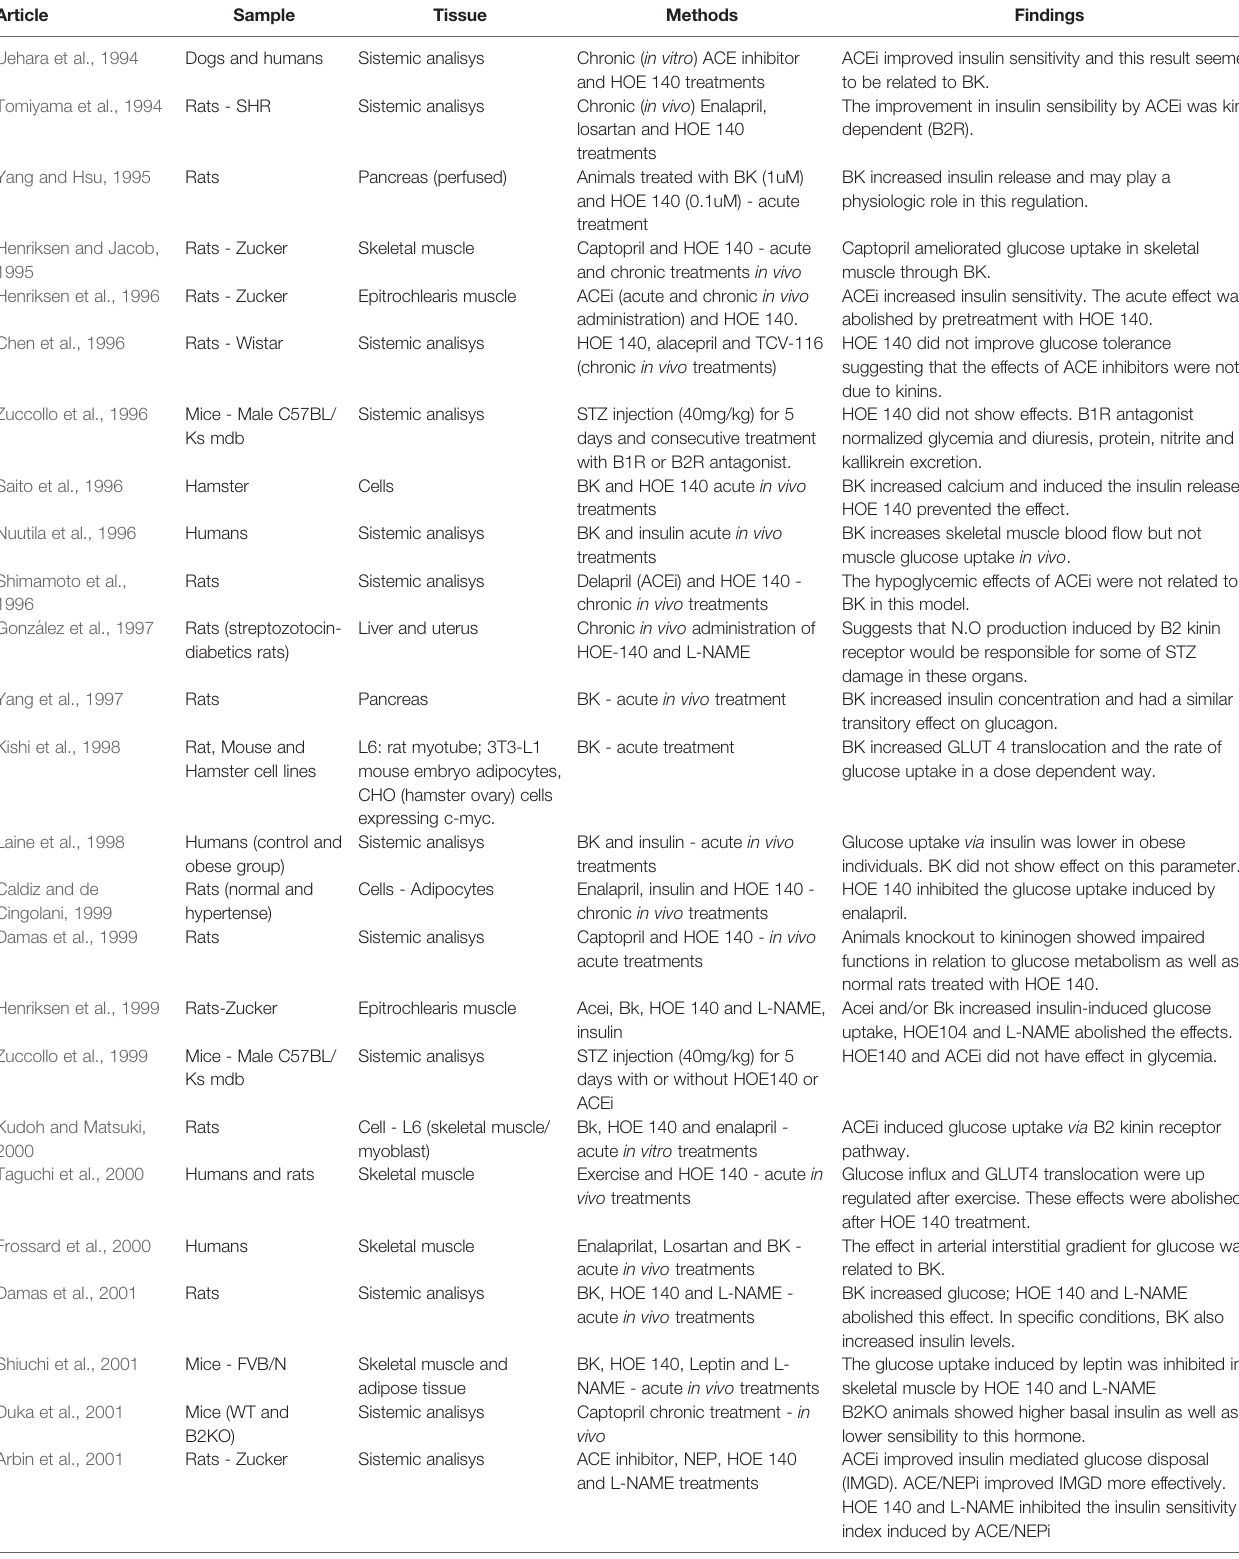
TABLE 1 | Summarized data of selected